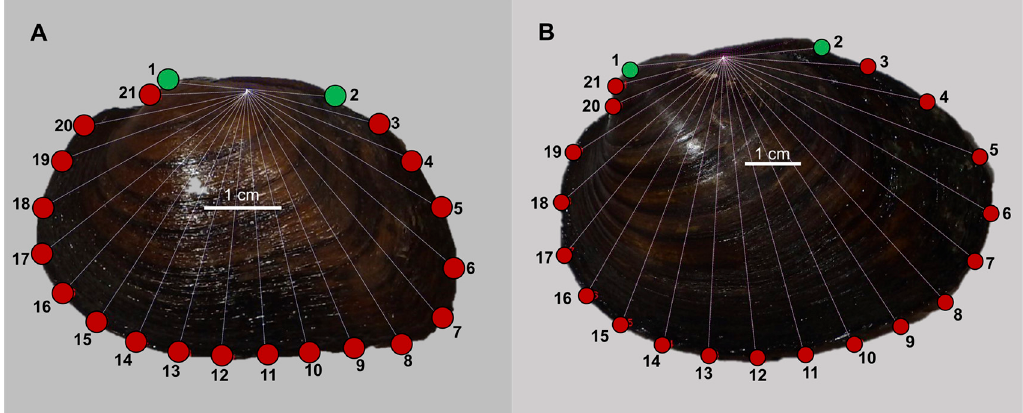
Figure 1. Typical F. flava ( A ) and P. sintoxia ( B ) specimens showing position of 21 digitized landmarks. Homologous type I landmarks (1 and 2) at the tip of the umbo and posterior end of the hinge ligament are shown in green. Type II landmarks (3–21 in red) along the shell margin were placed using a fan anchored at the median point between landmarks 1 and 2.